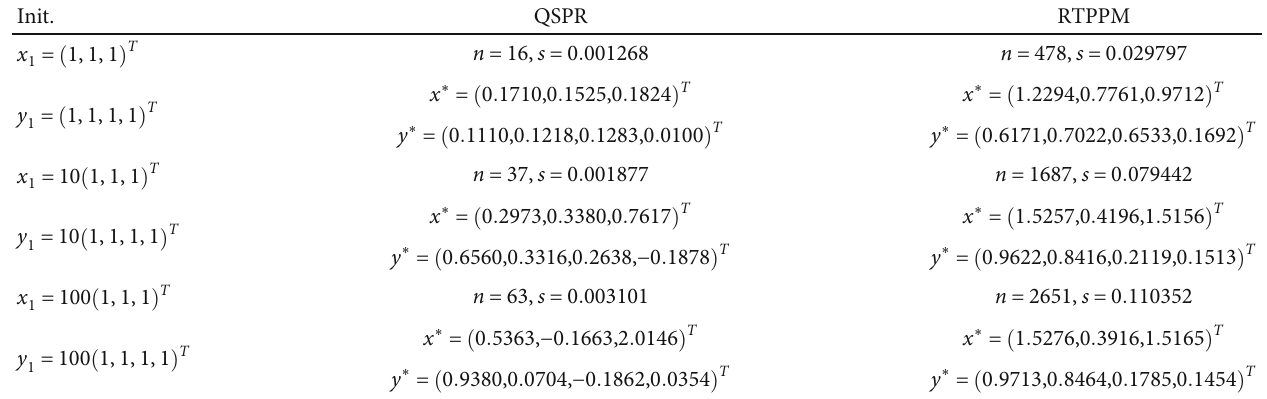
Table 2: The numerical results of Example